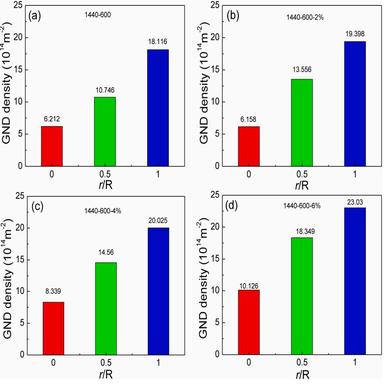
GNDs of 1440–600 sample after tensile deformation of (a) 0%, (b) 2%, (c) 4%, and (d) 6%.